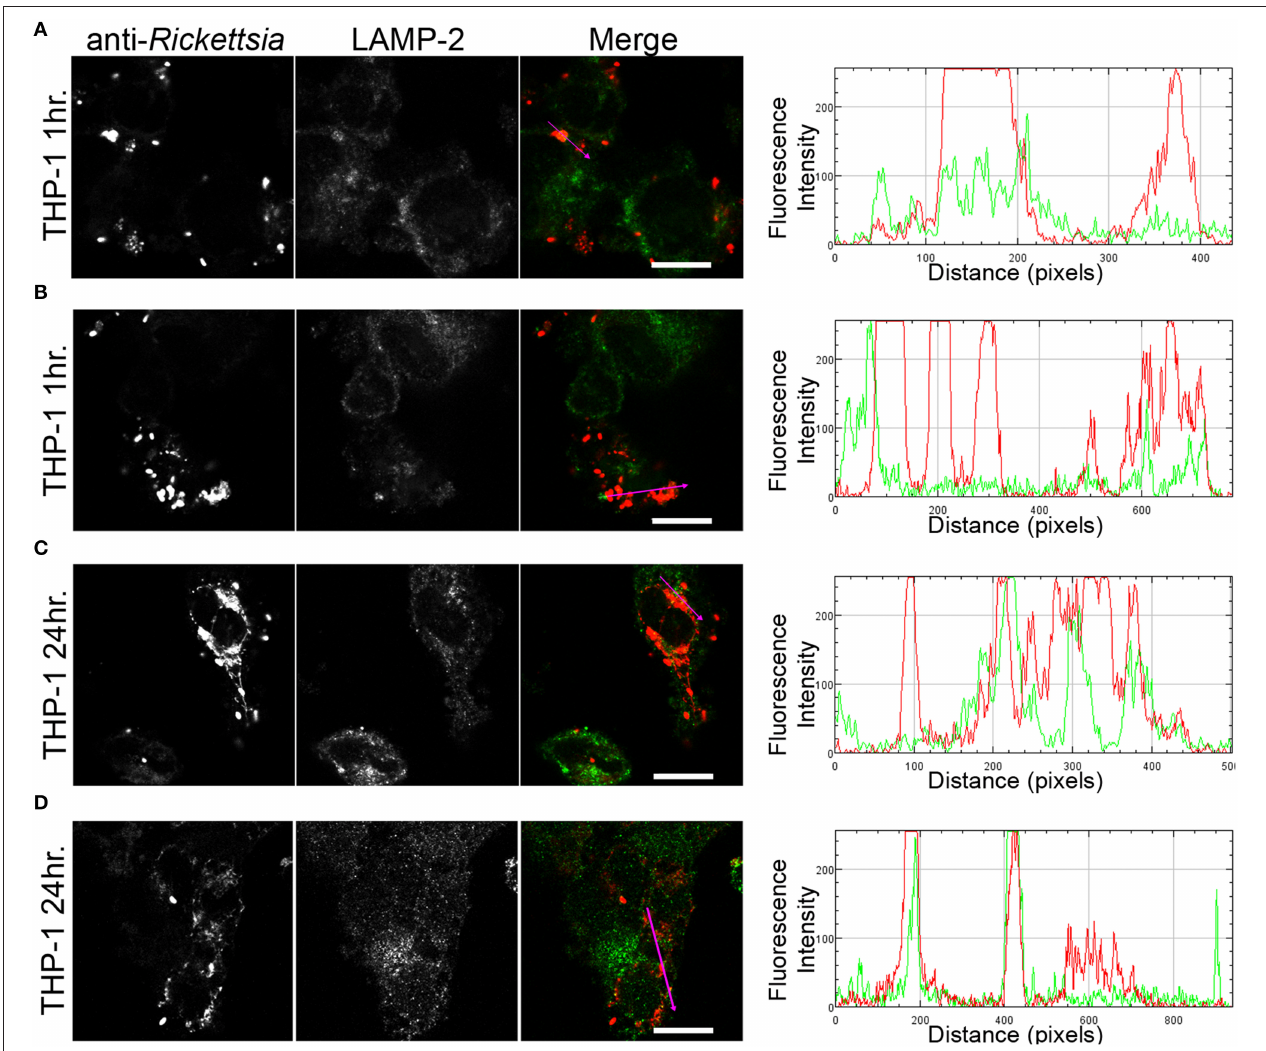
FIGURE 5 | R. montanensis is rapidly destroyed in THP-1-derived macrophages. THP-1-derived macrophages were infected with R. montanensis (MOI = 10). At 60 min or 24 h post infection, cells were fixed, permeabilized, and double stained for immunofluorescence confocal microscopy analysis with NIH/RML I7198 followed by Alexa Fluor 546 (red) to stain R. montanensis, and the monoclonal antibody for LAMP-2, lysosomal membrane protein followed by Alexa Fluor 488 (green). (A–D) Representative images of a single slice from the z stacks. THP1-derived macrophages at 60 min post infection (A,B) and 24 h post infection (C,D) . Each row shows, from left to right, Rickettsia staining, LAMP-2 staining, the merged image, and a RGB plot profile illustrating the fluorescence intensity along the magenta arrow. Scale bar = 10 µ m. Supplementary Movies 1, 2 represent 360 ◦ rotation movie of the 3D projection of the stack images shown in (A) and (C) ,